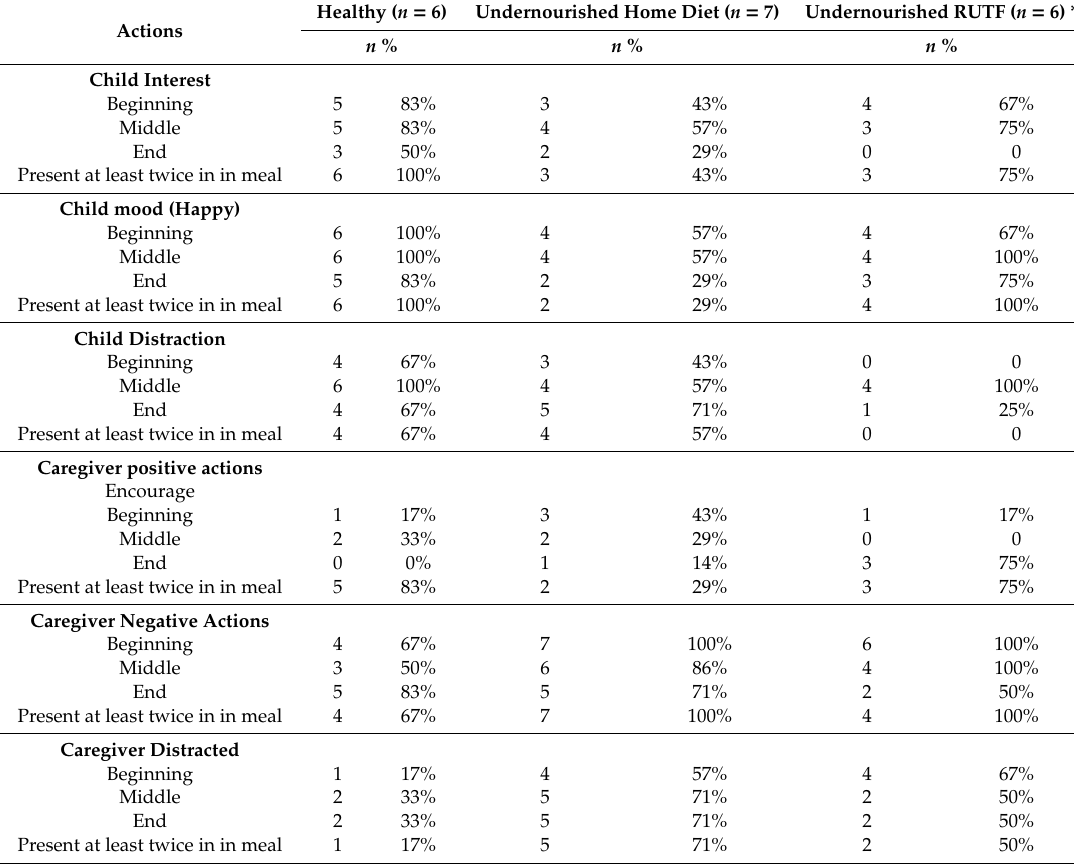
Table 4. Summary of child eating and caregiver feeding behavior during meals ( n =